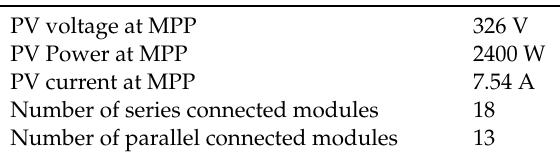
Table 1. Design of photovoltaic (PV)